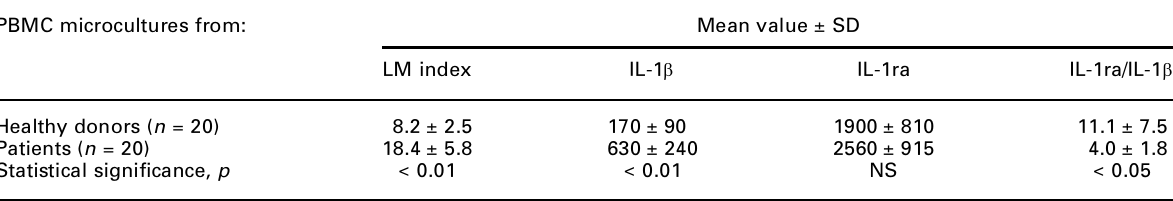
Table 5. LM values, IL-1 b , IL-1ra concentrations (pg/ml) and IL-1ra/IL-1 b concentration ratios in microcultures of peripheral blood mononuclear cells (PBMC) from healthy donors and from patients with acute infections of the upper respiratory tract PBMC microcultures